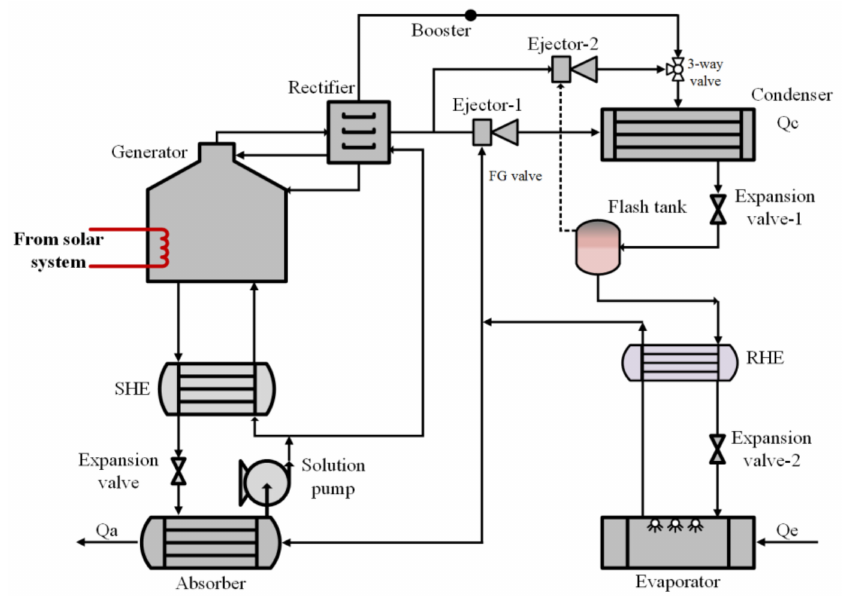
Figure 9. Schematic of DEARS with flash tank and RHE [73].